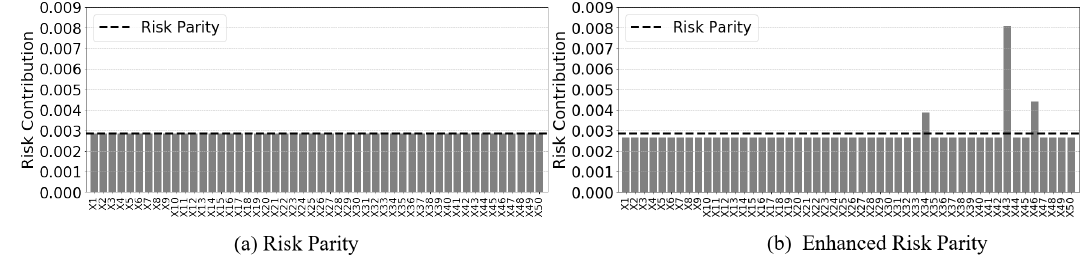
Figure 2. Risk contribution concentration in Model (A)—50 assets, 1997 to